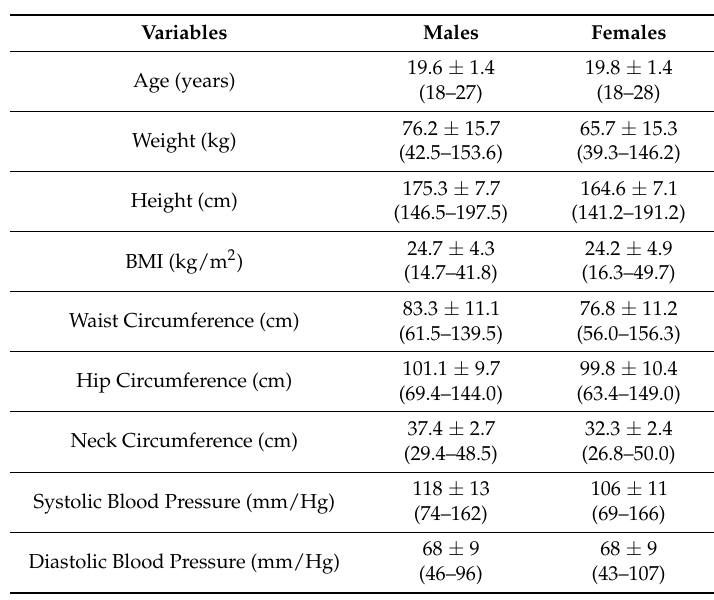
Figure 1. Receiving operating characteristics (ROC) curves determined from the neck circumference and central obesity (waist circumference >102 cm in males ( left ) and >88 cm females ( right )). Table 1. Subject characteristics.